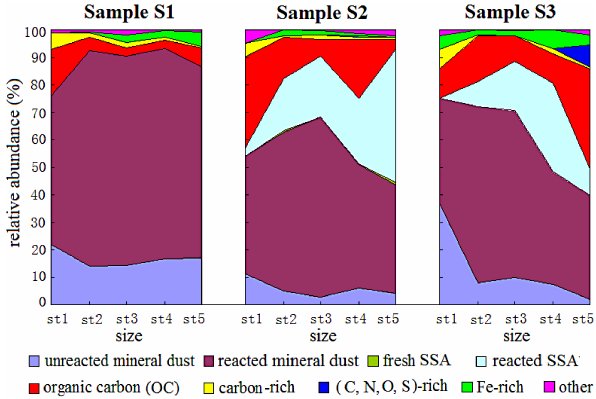
Fig. 7. Relative abundance percentages of various types of particles on stages 1–5 in samples S1–S3.